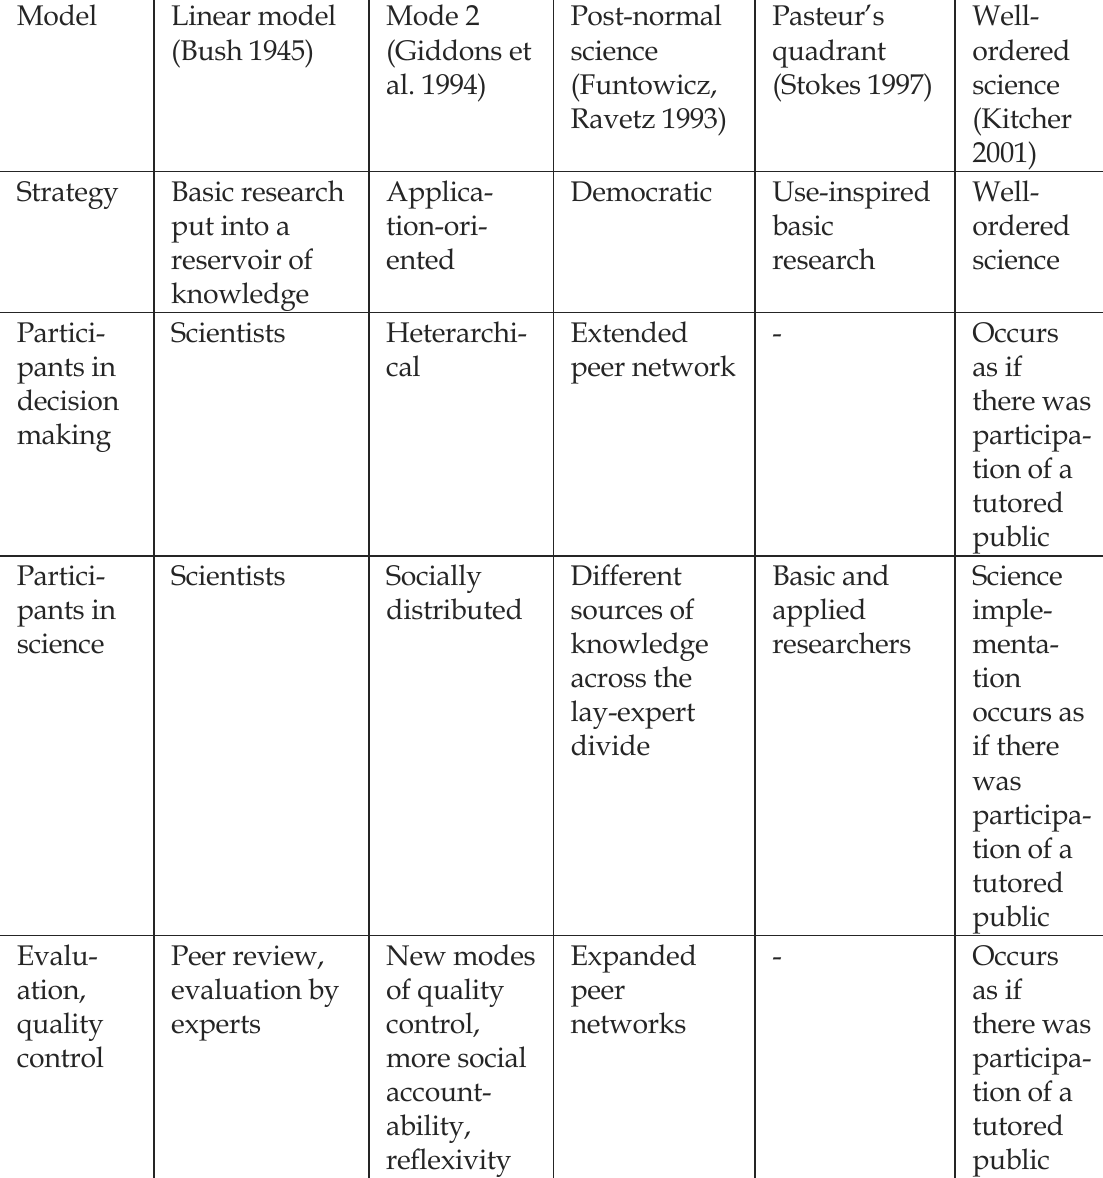
Table 1. Characteristics of different science policy models.